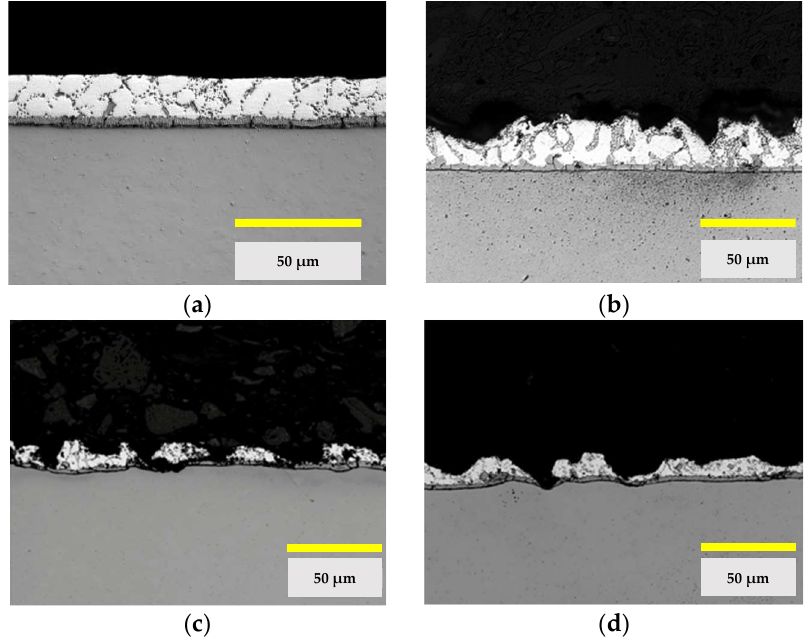
Figure 7. Micrographs of the Al-Si coating of the steel sheet DX1D + AS120, ( a ) state of supply; ( b ) after thermal cycle 2 and abrasive projection with brown corundum at 0.2 MPa for 5 s; ( c ) for 10 s and ( d ) for 15 s.